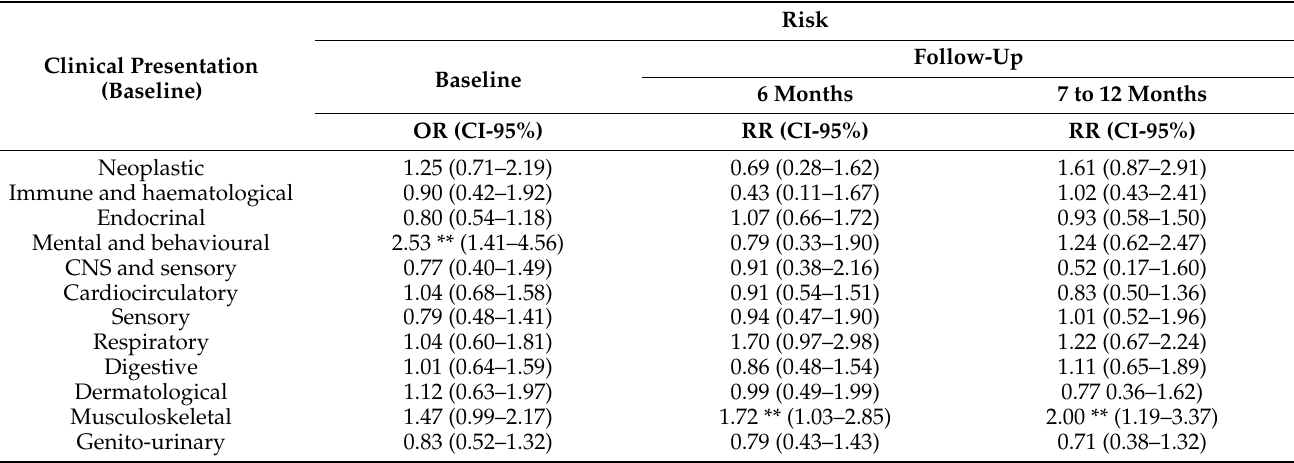
Table 7. Relationship between falls and previous